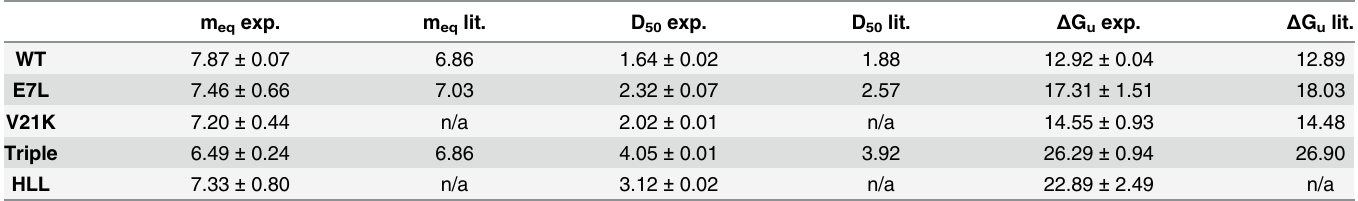
Table 2. Summary of equilibrium data collected using the plate reader method. All proteins are WT or mutants of AbpSH3 except HLL. The literature m eq and D 50 values for V21K were omitted as they were only recorded using urea and not guanidine. “ Lit ” indicates the literature value and “ exp ” the experi- mental value measured in this study, “ n/a ” indicates that there is no literature value available for comparison. D 50 units are M, m eq units are kJ mol -1 M -1 , and Δ G -1 . u units are kJ mol m eq